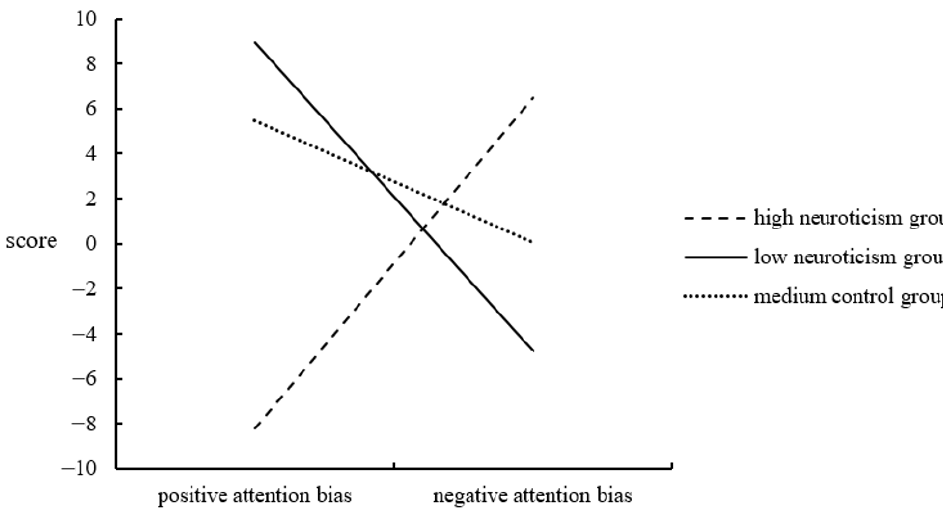
Figure 6. Interaction between the attention bias type and the neuroticism group.